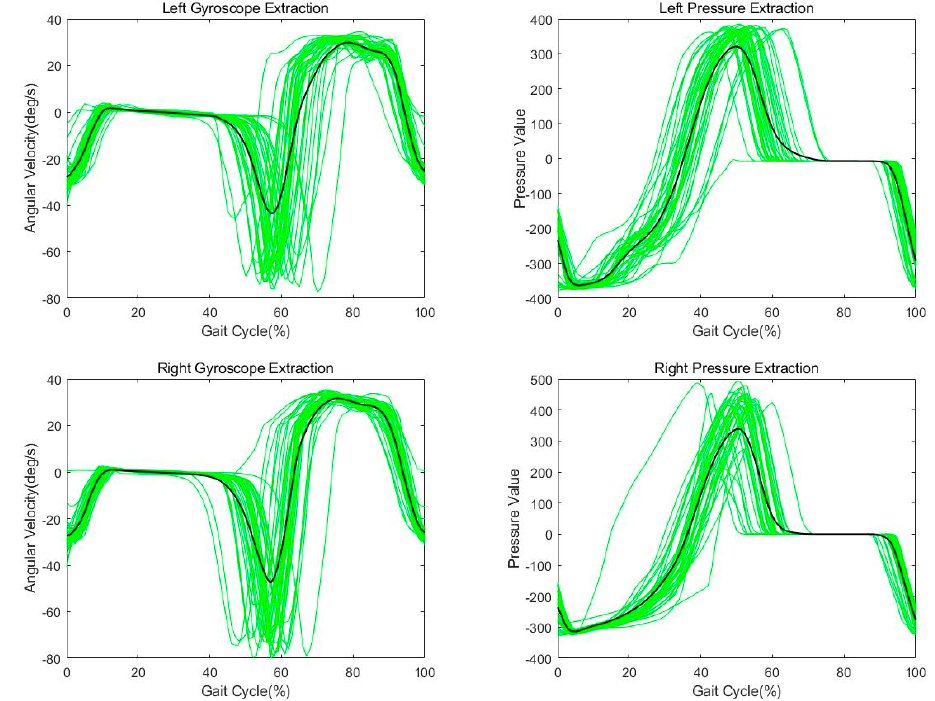
Figure 10. Stride extraction and mean from the gyroscope/pressure data.